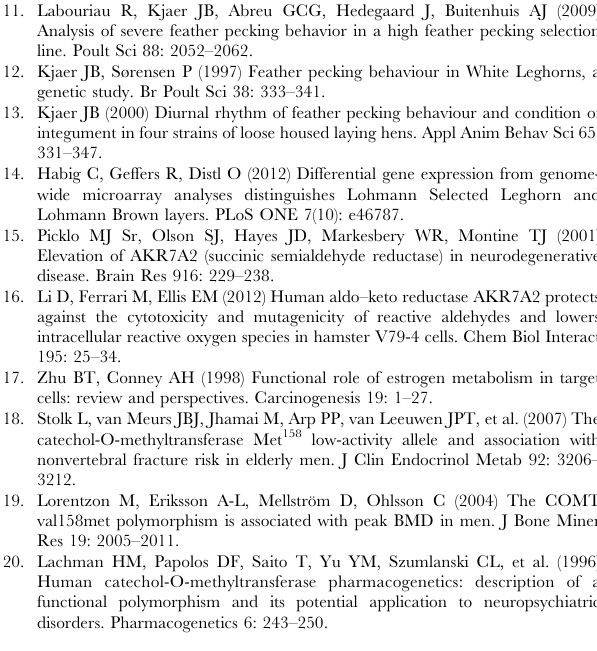
enriched and unenriched terms, black dashed edges stand for relationship between two unenriched GO terms. Each box represents a GO term, labeled by its GO-ID, the term definition, the P-value and detail informations. Figure S4 Arrangement and dimensions of the com- partments of the small group housing system. A Cross section drawing of a single compartment. B Individual compart- ment for group sizes of 54 laying hens in a top view drawing. C Arrangement drawing of the tiers (A: first tier; B: second tier; C: third tier), layer lines (LB: Lohmann Brown; LSL: Lohmann Selected Leghorn) and group sizes (36 and 54 hens) of the small group housing system Eurovent German. Table S1 Differentially expressed probe sets between the Lohmann Selected Leghorn (LSL) and Lohmann Brown (LB) laying hens. Table S2 Enriched biological processes of probe sets with different expression in comparison between LSL and LB.